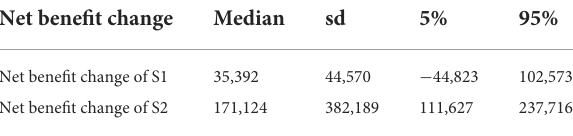
TABLE 8 Distribution of net benefit change of S1 and S2 from stochastic